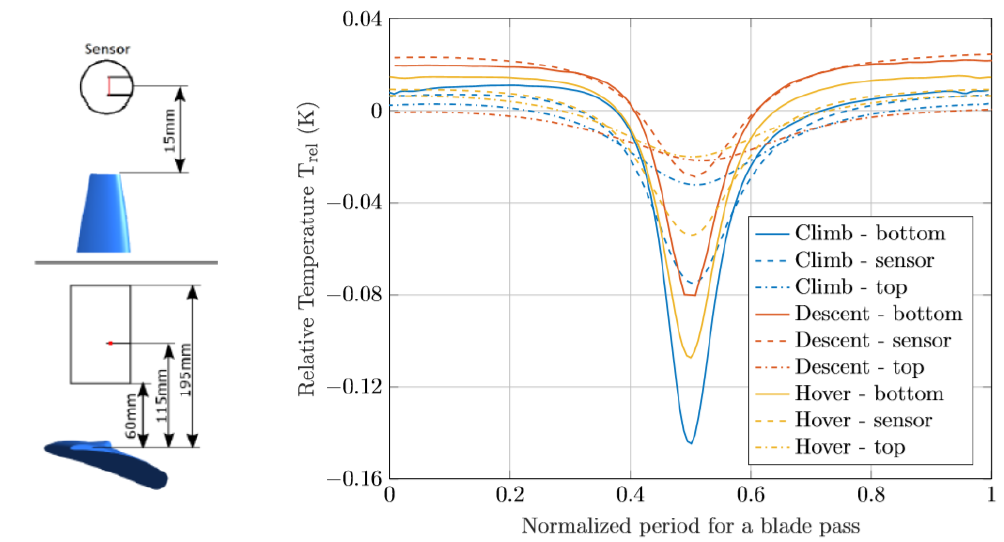
Figure 9. ( Upper left ): Top view of geometry of fine-wire temperature sensor and housing, and its relative positioning to the rotor blade (blue) at closest approach. ( Lower left ): Side view of the propeller blade (blue), the housing and the location of the fine-wire sensor within the housing. ( Right ): Relative temperature changes during a blade pass for different states (hover, climb, descent) and different locations of the sensor with respect to the propeller blades.